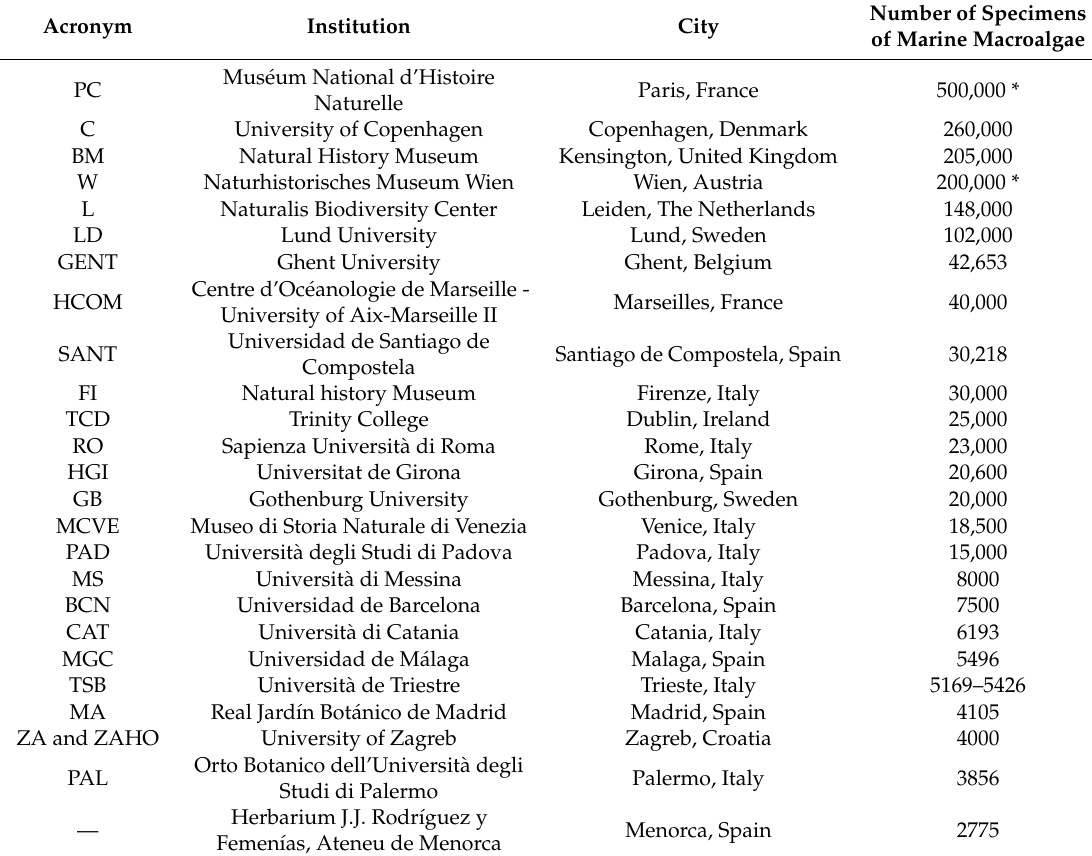
Table 1. European herbaria hosting consistent marine macroalgae collections. The acronym of the herbaria in the Index Herbariorum [27] is also included. The number of specimens of herbaria labelled with *, includes freshwater algae and marine